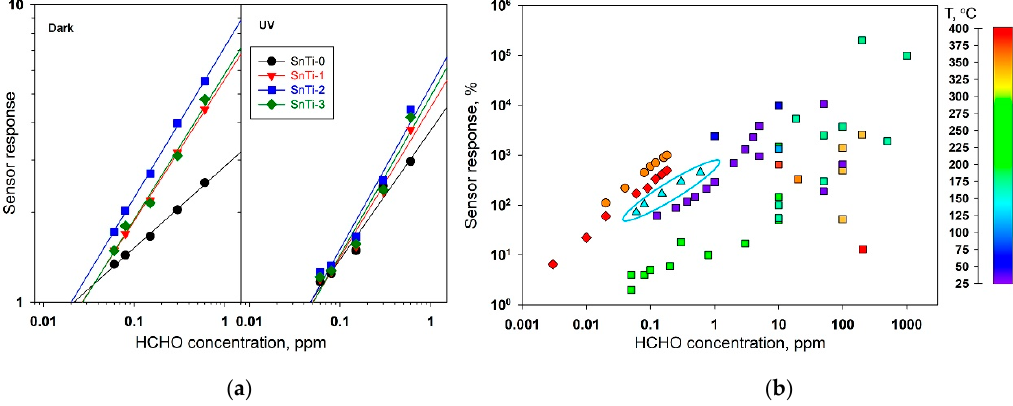
Figure 13. ( a ) Calibration curves for the HCHO detection using TiO 2 @SnO 2 nanocomposites at T = 150 °C under stepwise change of the HCHO concentration in dark conditions (left) and under UV periodic illumination (right). ( b ) Comparison of the values of the sensor response of SnTi-2 nanocomposite (triangles) with the literature data [8–11,20–23,28,87–117] (squares), Ref. [7] (diamonds) and Ref. [86] (circles). The color of the symbol corresponds to the measurement temperature. For correct comparison all the data were recalculated as S = ( R air / R gas - 1)*100%. Table 4. Sensor characteristics of unmodified SnO 2 and TiO 2 @SnO 2 nanocomposites in HCHO detection at 150 ◦ C.